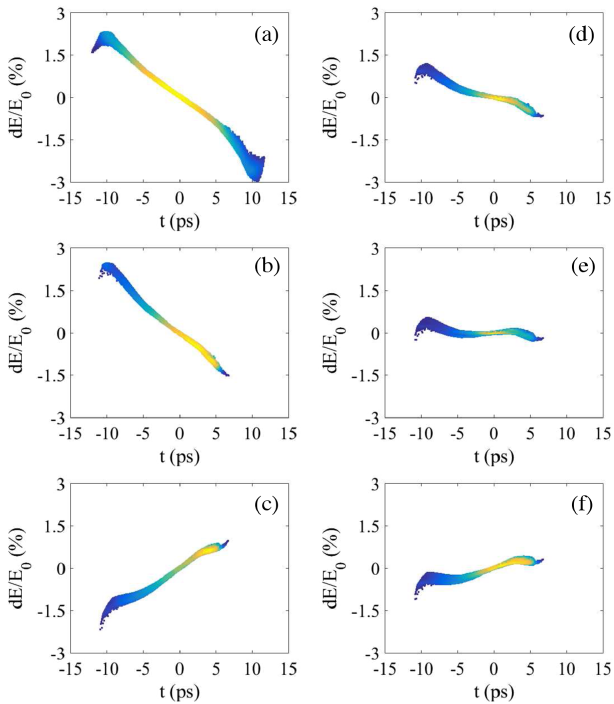
FIG. 7. Start-to-end simulation results to demonstrate chirp control capability. Longitudinal phase space (a) of a 60-nC bunch at the entrance to the shaping beam line and (b) – (f) at the exit to the shaping beam line with a mask for a doorstep profile. (b) and (c) are the results from 2 TDC þ 1 Q and 3TDC beam lines, respectively. (d) – (f) share the 3 TDC þ 2 Q beam line, while they use different first quadrupole strengths: (d) 1.0, (e) 0.75, and (f) 0.5